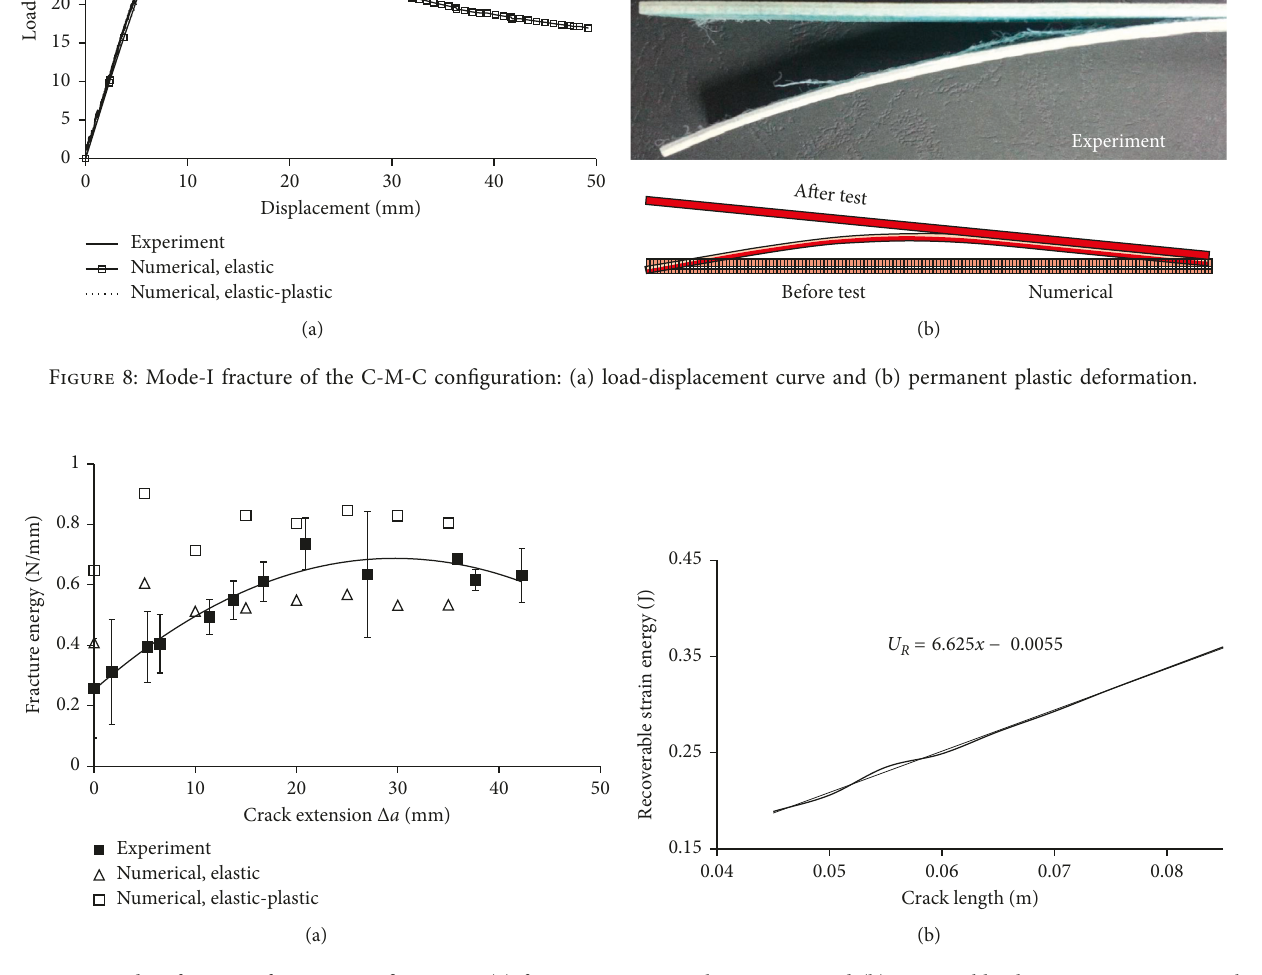
Figure 9: Mode-I fracture of C-M-C configuration: (a) fracture energy-crack extension and (b) recoverable elastic strain energy-crack length variation. Table 3: Summary of fracture energy determined using C-M-C